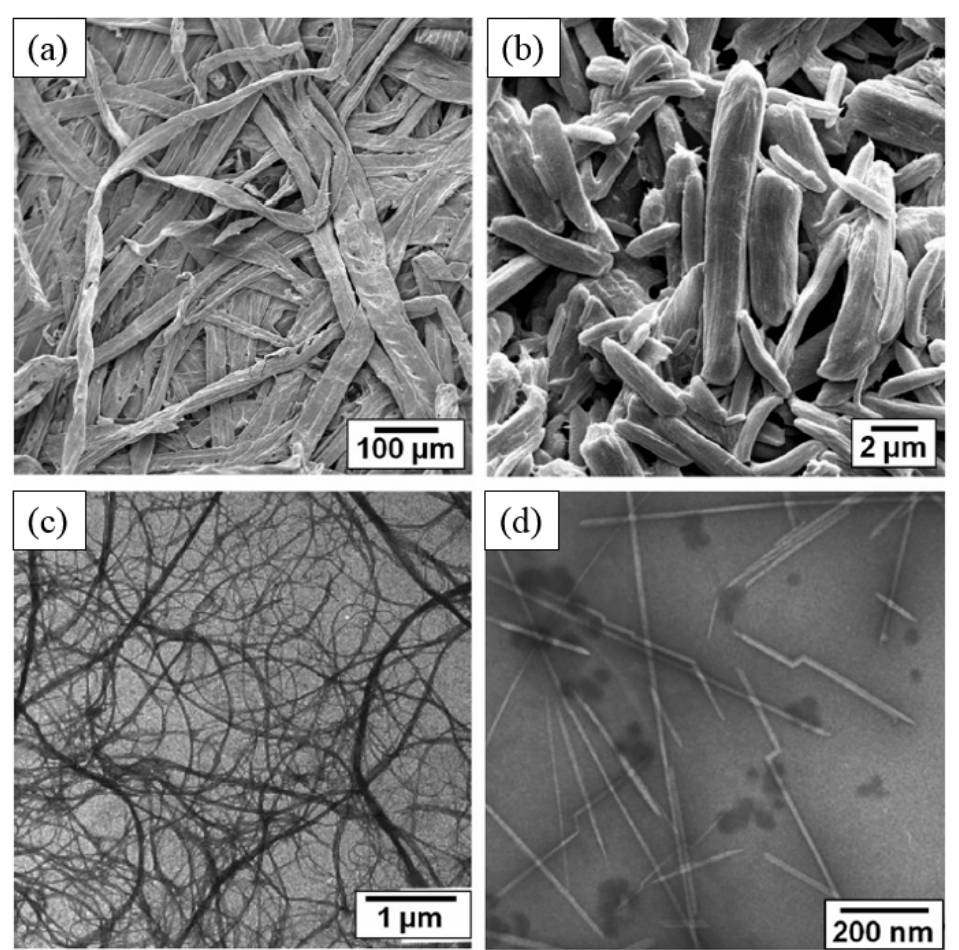
Figure 2. SEM images of different cellulose particle types: ( a ) wood fiber; ( b ) MCC; ( c ) microfibrillated cellulose; and ( d ) tunicate cellulose nanocrystals (adopted from [1]).